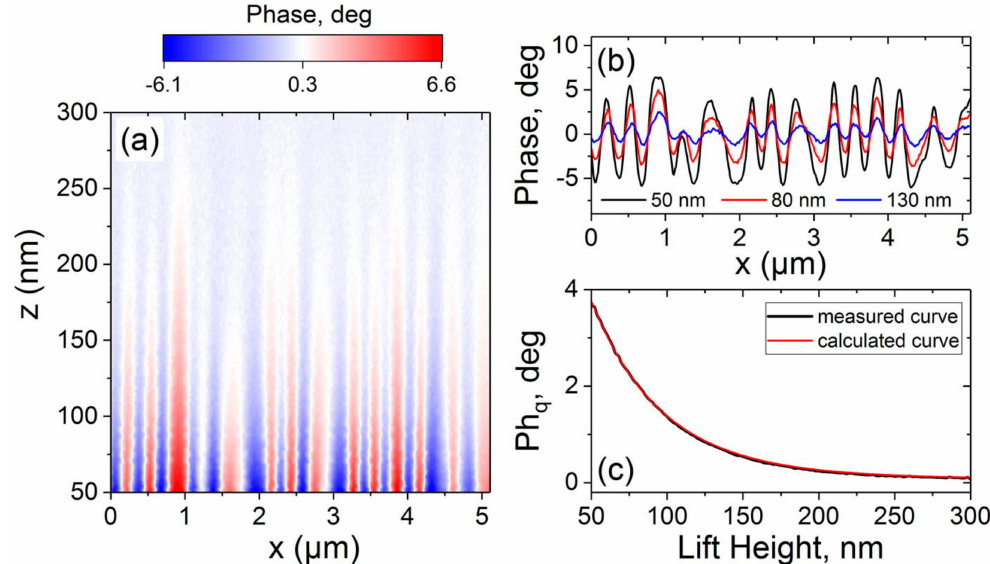
Figure 7. ( a ) An MFM phase image measured in the MFMZ mode when the lift height H is changed from 50 nm to 300 nm; ( b ) cross-sectional phase profiles measured at the lift height of 50 nm, 80 nm, and 130 nm, respectively; ( c ) the relationships between the measured phase signal strength (black) and calculated signal strength (red) vs. lift height. Reprinted from [74] and originally published under a CC-BY